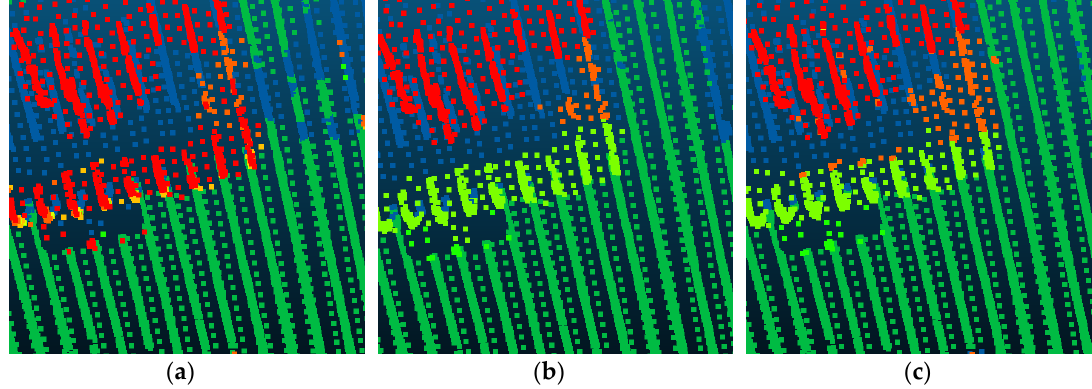
Figure 8. The detailed improvement of fence/hedge classification. ( a ) The Point_S result. ( b ) The SegT_M result. ( c ) The ground truth.